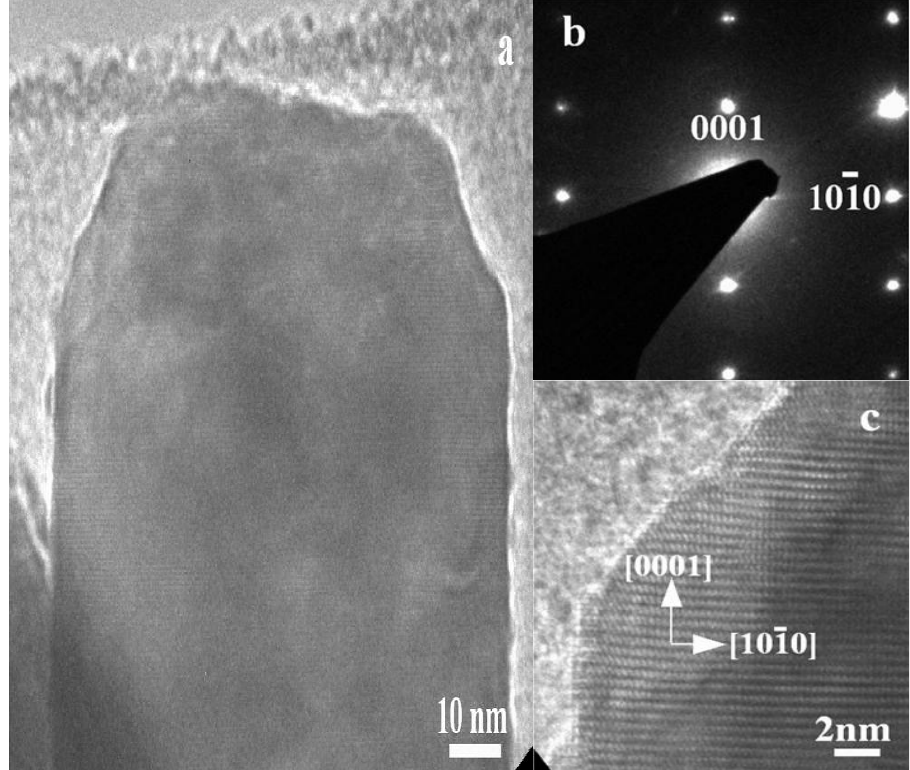
Figure 3. The HRTEM image of the ZnO nanorod grown with the seed solution of 70 mg of ZnO nanoparticles present in the chitosan